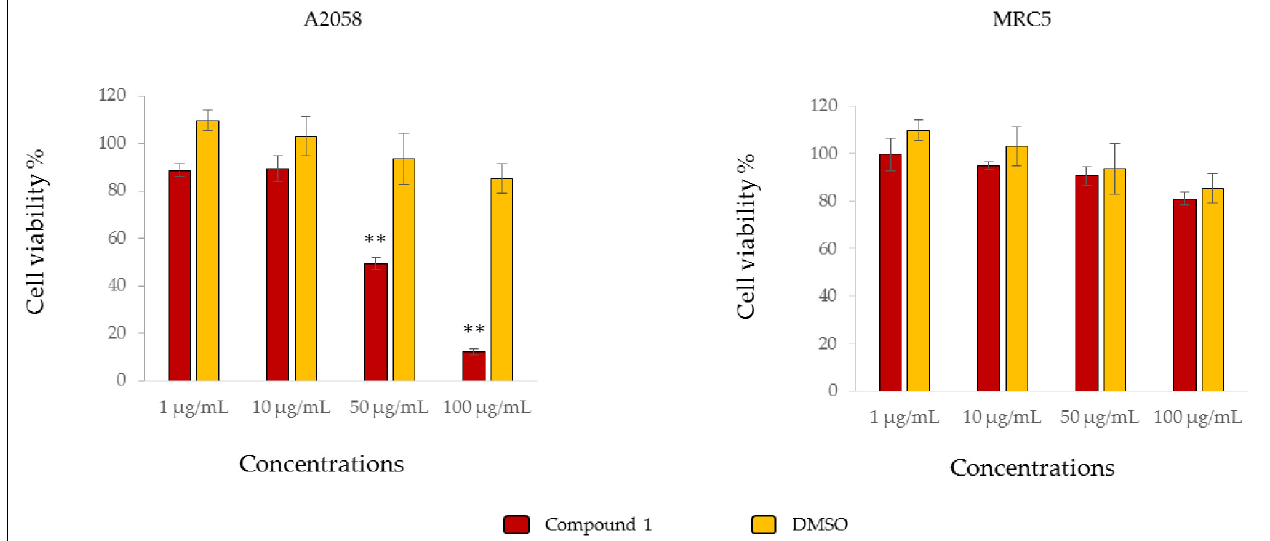
FIGURE 6 | Antiproliferative assay. The histograms show antiproliferative effects of Compound 1 on A2058 cell line (melanoma) and MRC5 (normal cell line) and the respective controls only with the vehicle (DMSO). Results are expressed as percentage of cell survival after 72 h exposure ( n = 3). Cell growth was expressed as the percentage of cell viability with respect to the vehicle for each concentration ∗∗ p <